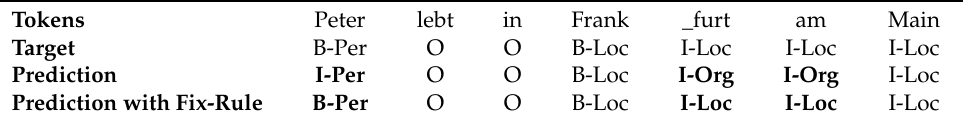
Table 5. Example for the Entity-Fix rule. Rows refer to the tokens, its respective target, prediction, and the prediction resulting from decoding with the Entity-Fix rule. Changes are emphasized in